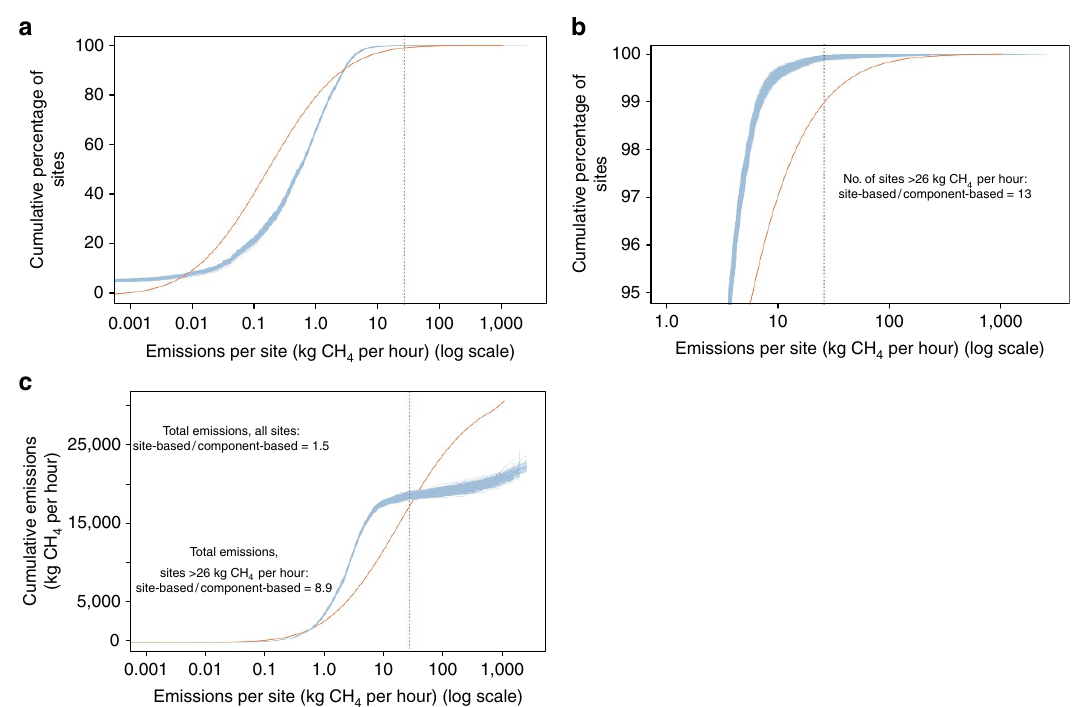
Figure 2 | Distribution of methane emissions from production sites in the Barnett Shale. ( a ) Cumulative percentage of sites as a function of the emission rate per site. In ( b ) we show the 5% of sites with highest emissions; ( c ) cumulative emissions as a function of emission rate per site. Blue lines represent each of 10 4 Monte Carlo iterations from the component-based aggregation reported in this work; orange lines represent the site-based results derived from Zavala-Araiza et al. 21 ; vertical lines represent the 99th percentile of site emissions in Zavala-Araiza et al. 21 (26kg CH 4 per hour). Inset text show ratios between site-based and component-based estimates for given metrics.